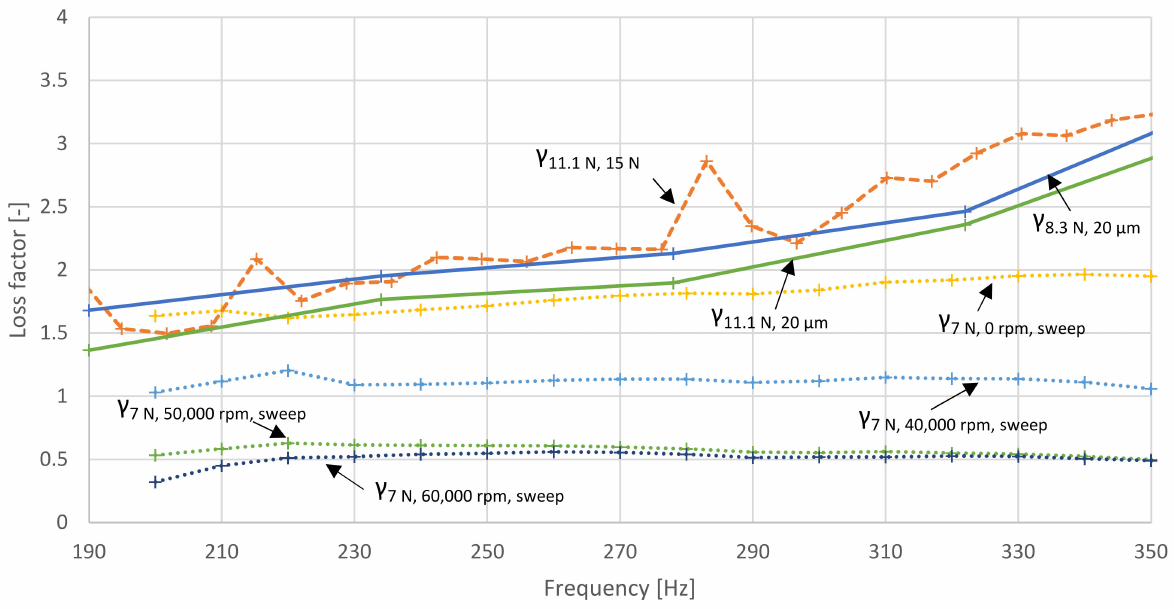
Figure 16. Comparison of loss factors (Equation (1)); first index: static load; second index: controlled force (N) or displacement ( µ m) amplitude or results from different rotation